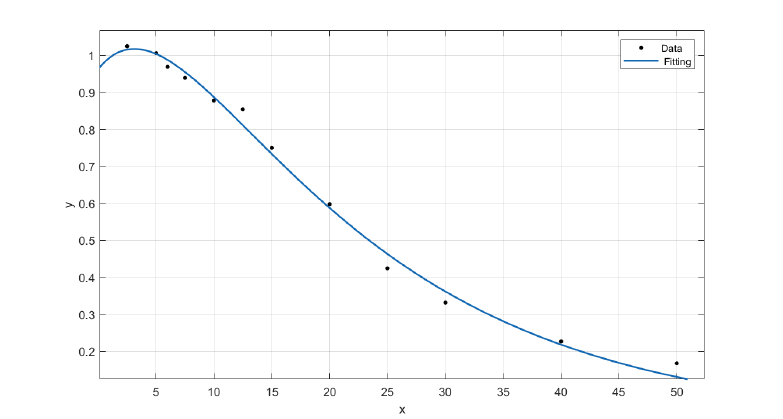
Figure 13. Fitted curve of the attenuation coefficient of the maximum induced voltage—Case B.